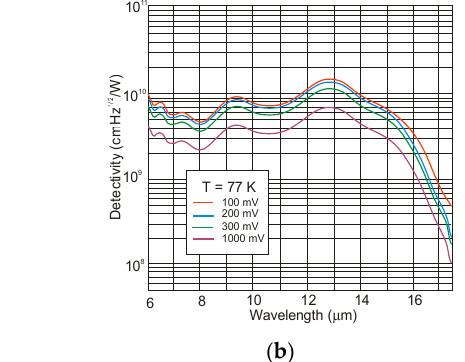
Figure 59. Dark electrical characteristics of LWIR InAs/InAsSb SL photodiodes: ( a ) current-voltage characteristics versus temperatures; ( b ) R o A versus temperature (after [164]).